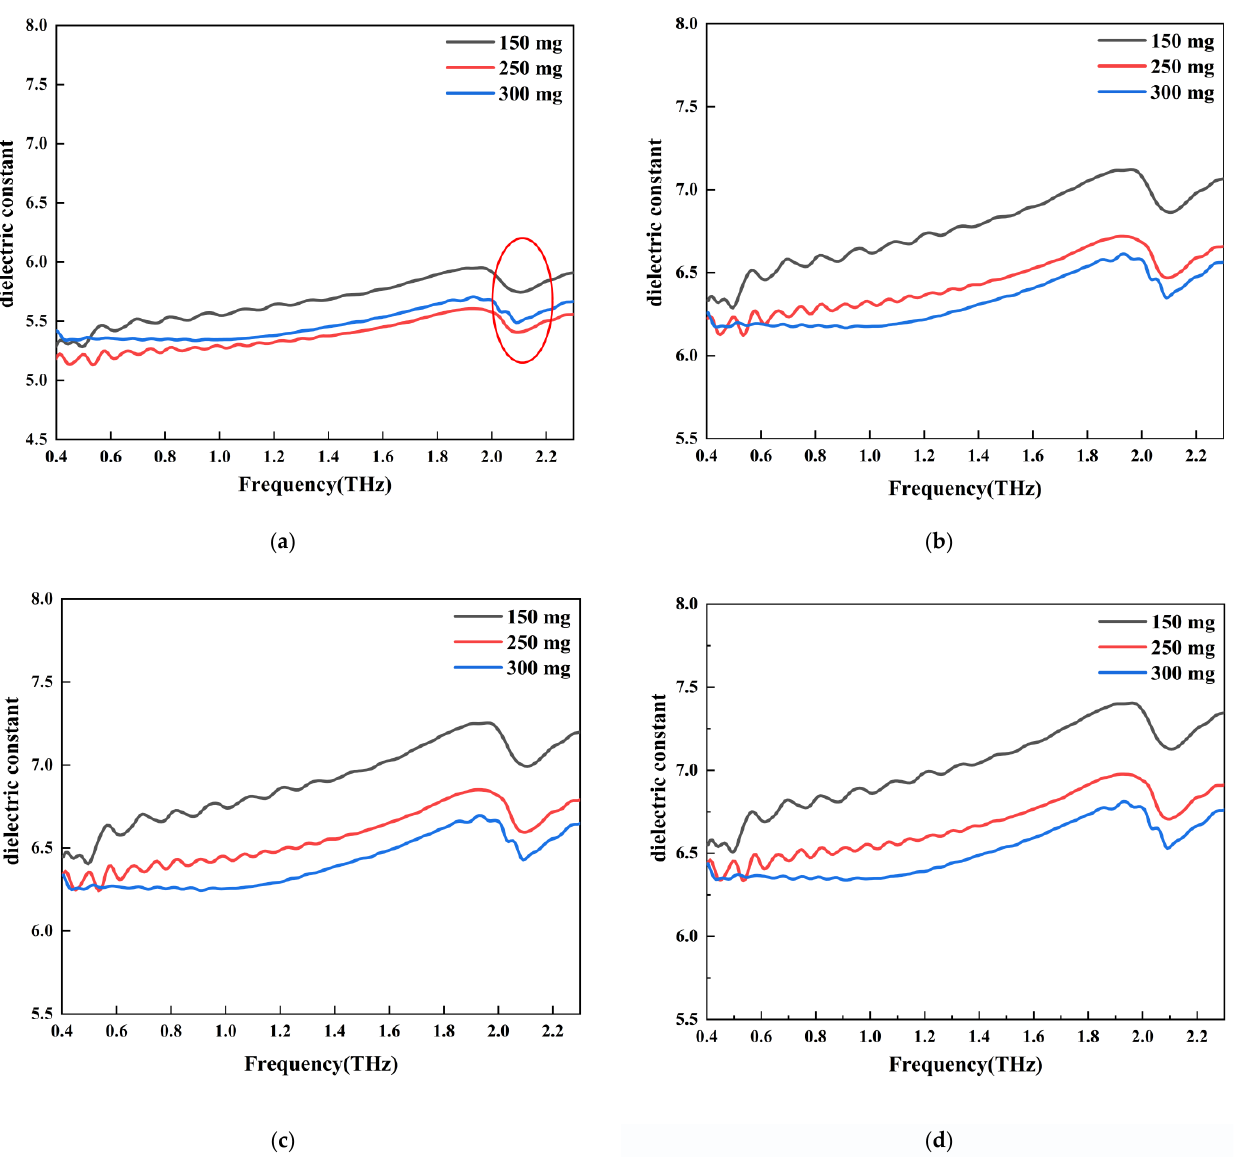
Figure 8. THz dielectric spectra of C 3 S samples with different mass obtained from the experimental test and the intrinsic dielectric spectrum processed by the model: ( a ) C 3 S dielectric constant spectrum (the red circle shows dielectric dispersion in 2.03THz); ( b ) MG model C 3 S intrinsic dielectric; ( c ) BM model C 3 S intrinsic dielectric constant; ( d ) LLL model C 3 S intrinsic dielectric